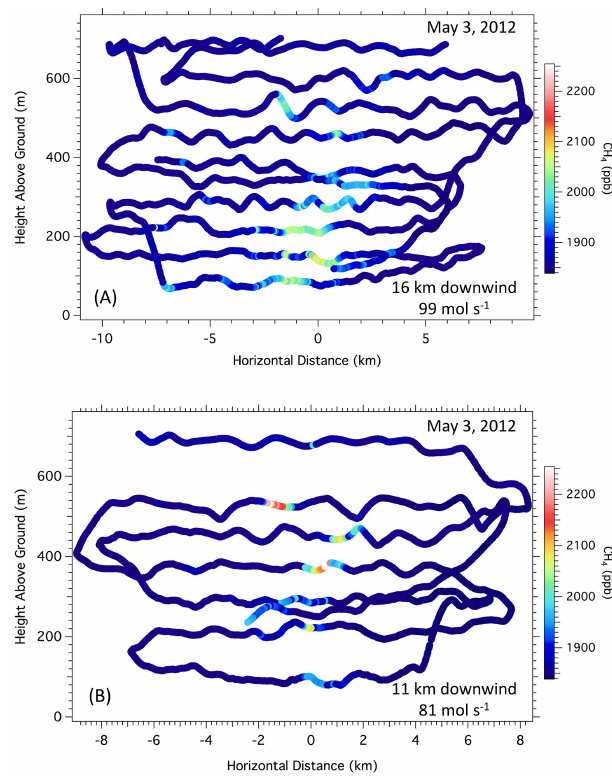
Figure 7. Observed methane concentrations for the 3 May 2012 Newton County landfill flight experiment for two downwind dis- tances: (a) 16km and (b) 11km. Vertical profiles were flown after the 16 and 11km horizontal transects, showing CBL depths of 700 and 840m,